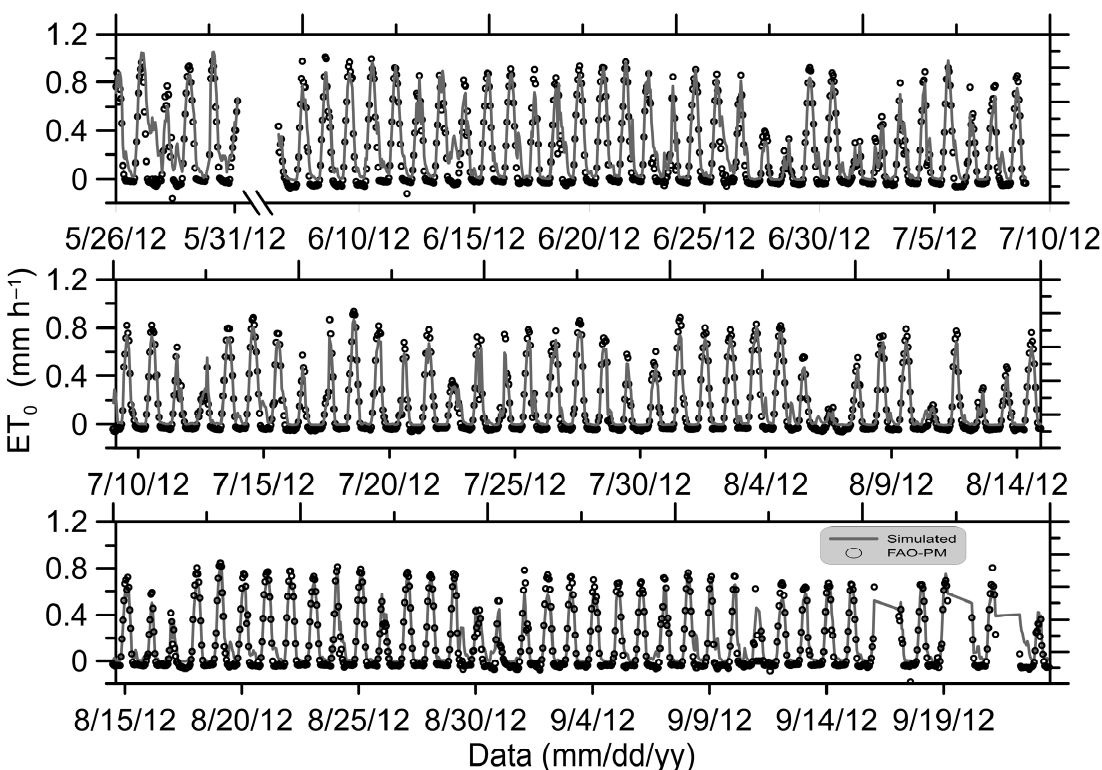
Figure 3. Seasonal variations in simulated reference evapotranspiration (ET 0 ) by two models during the growing season. The gray lines represent simulations by the reference soil-plant-atmosphere continuum (R-SPAC) model, whereas black dots represent simulations by the Penman–Monteith model by the Food and Agriculture Organization (FAO-PM).